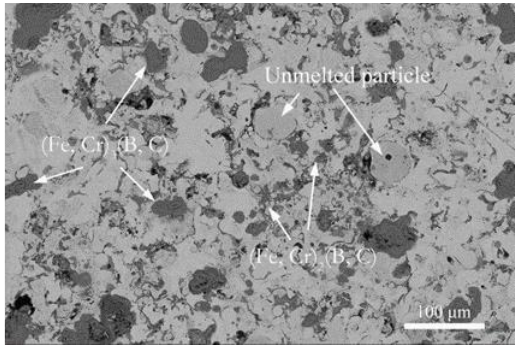
Figure 5. SEM morphology of the surface of the FeCrBC coating.